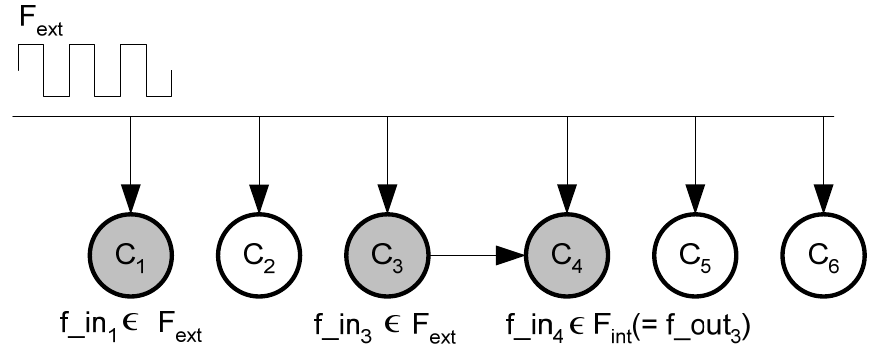
Figure 8. Activation of the system components. External activation signal F components C stand for activated